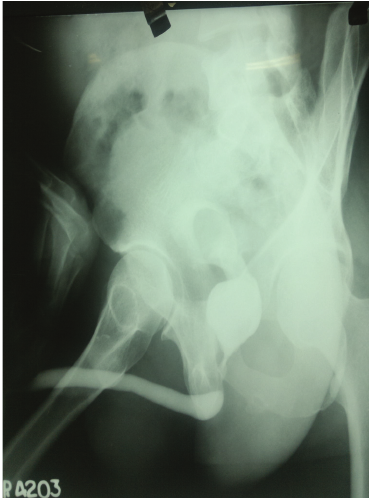
Figure 4: Retrograde cystourethrogram showing stricture of bul- bomembranous junction with dilated prostatic urethra with calcu-